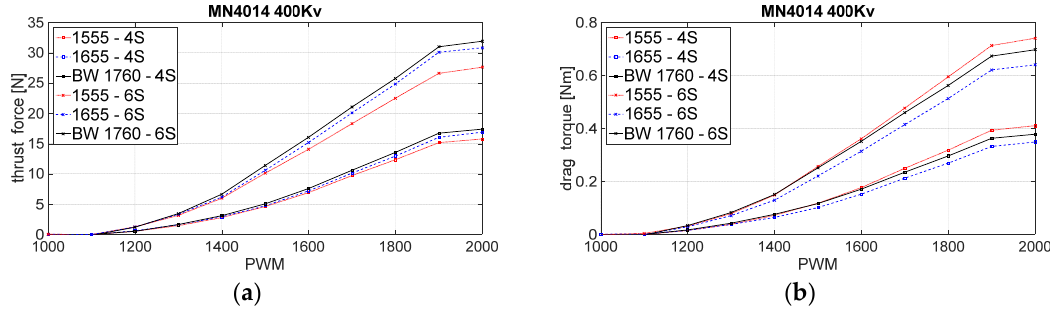
Figure 12. Static maps—MN 4014 BLDC motor: ( a ) thrust force; ( b ) drag torque.